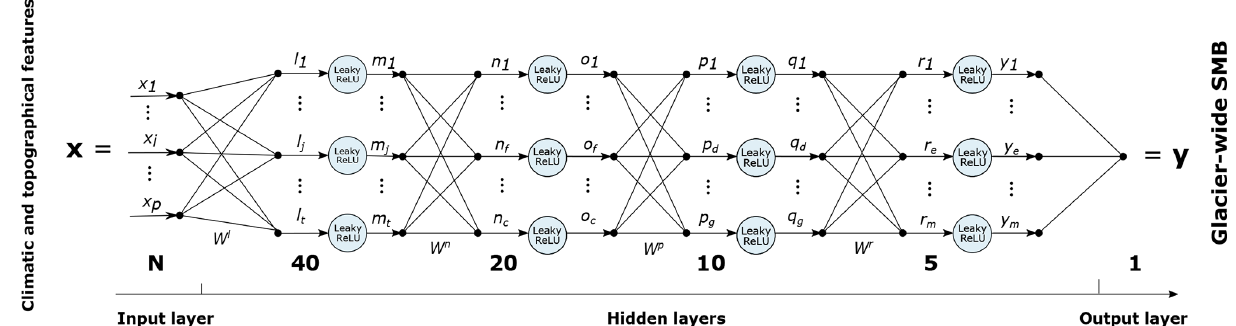
Figure 3. Deep artificial neural network architecture used in ALPGM. The numbers indicate the number of neurons in each